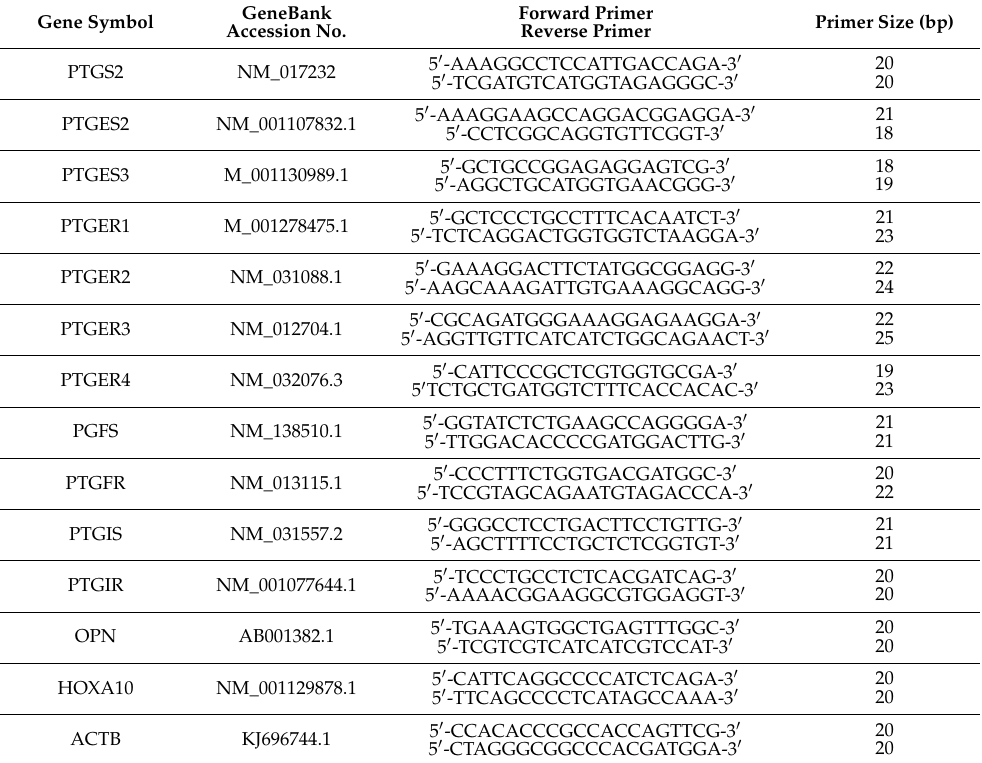
Table 1. Primers used for real-time